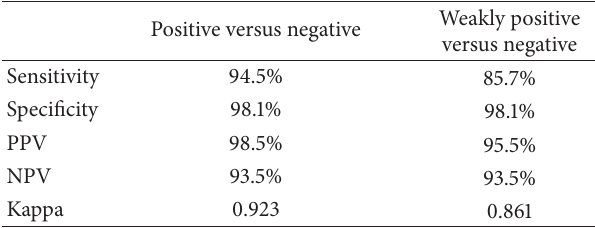
Table 2: Analytical performance of ICARE algorithm for ANA